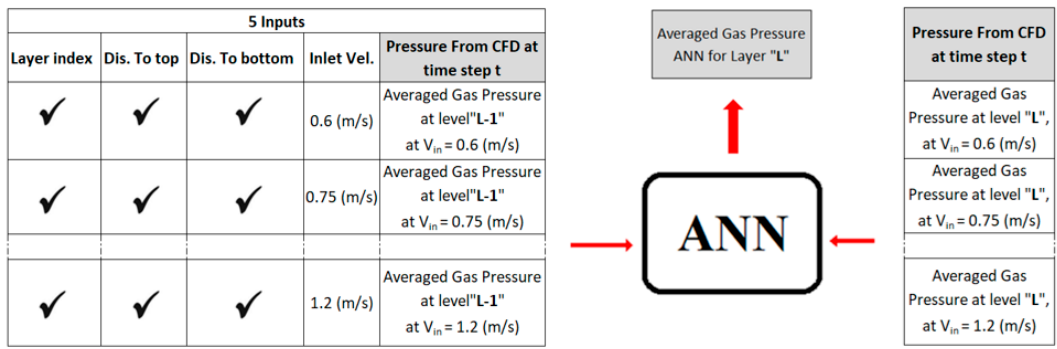
Figure 36. ANN deployment for average gas pressure using five parameters in cascading mode when information flows from upstream to downstream.